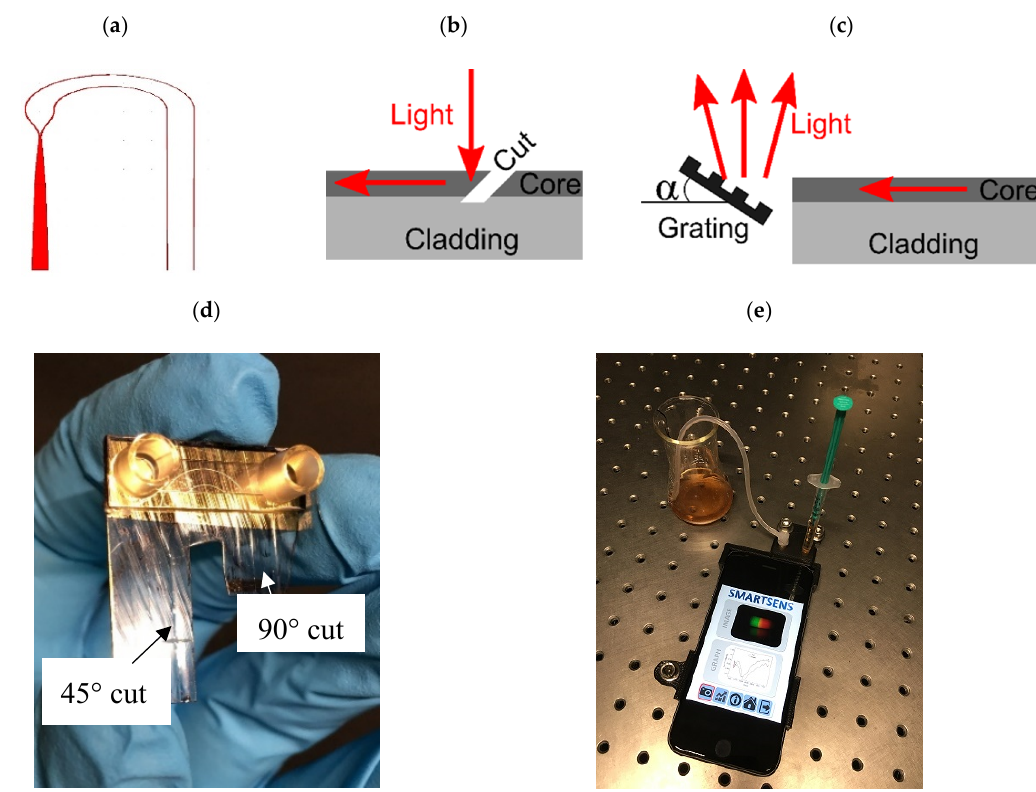
Figure 2. Schematic of the designed sensor system ( a ) as well as the applied light coupling structures to couple light into ( b ) and out of ( c ) the planar-optical waveguide sensor. For the light-in coupling a 45° cut and total internal reflection was applied, whereas for the light-out coupling a 90° cut and the diffraction grating in reflection mode was used. After assembling the coupling structures and the microfluidic ( d ), the sensor chip was embedded into a 3D printed sensor housing ( e ).